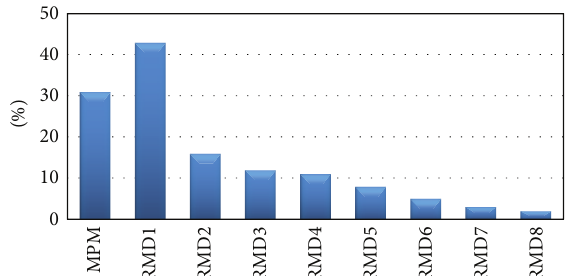
Figure 2: Runtime ratio of RMD and RDO in intraprediction coding.